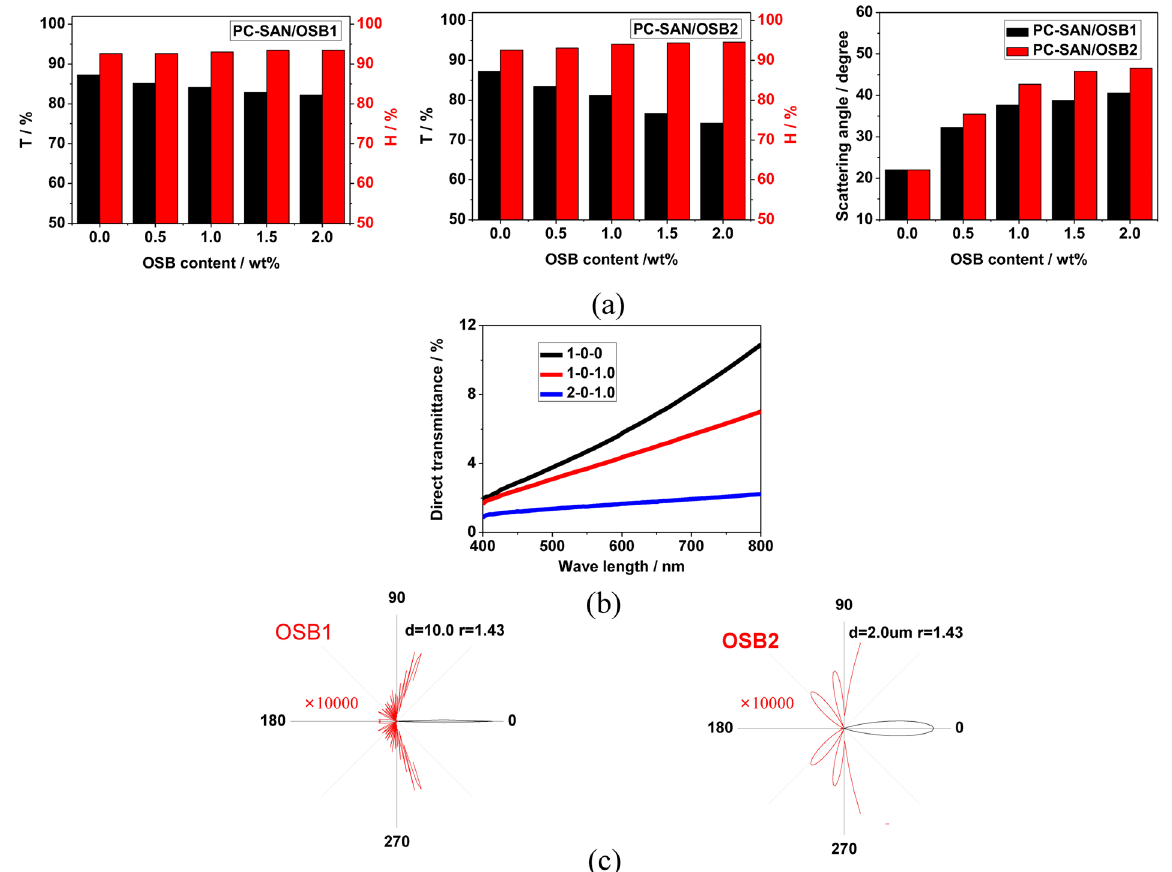
Figure 4. ( a ) The haze, transmittance and scattering angles of two groups with increasing content of OSB. ( b ) UV-Vis spectrum of samples. ( c ) Calculated scattering profiles of single particle with different size using Mie scattering